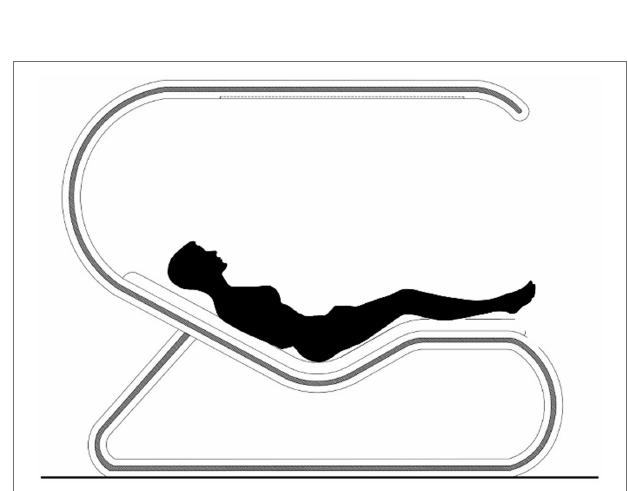
FIGURE 2 | Schematic representation of the Rebalance©